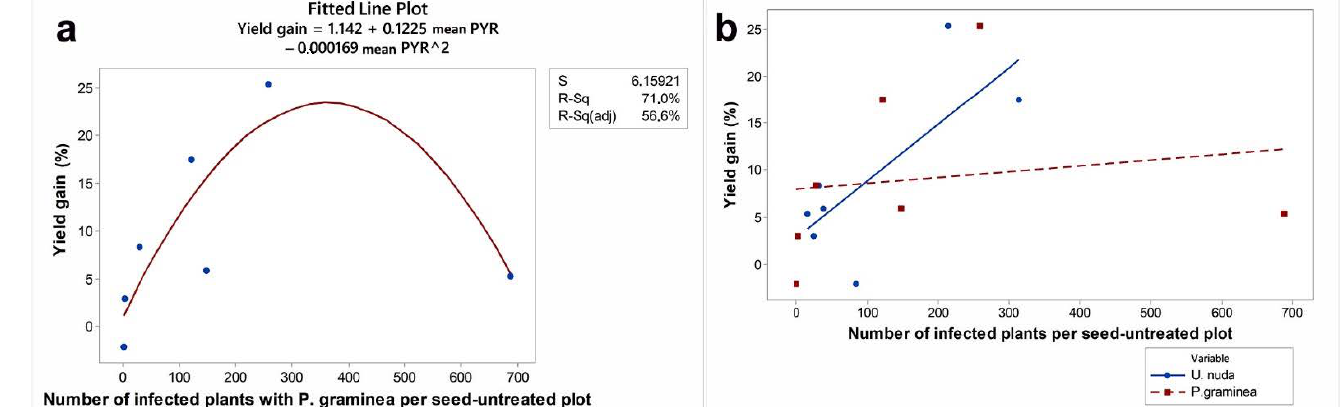
Figure 4. Regression analysis of the relationship between yield gain and pathogen pressure in the period 2014–2020: ( a ) Relationship between yield gain and total number of plants infected with P. graminea in the seed-untreated plot; and ( b ) relationship between yield gain and total number of plants infected with U. nuda in the seed-untreated plot.